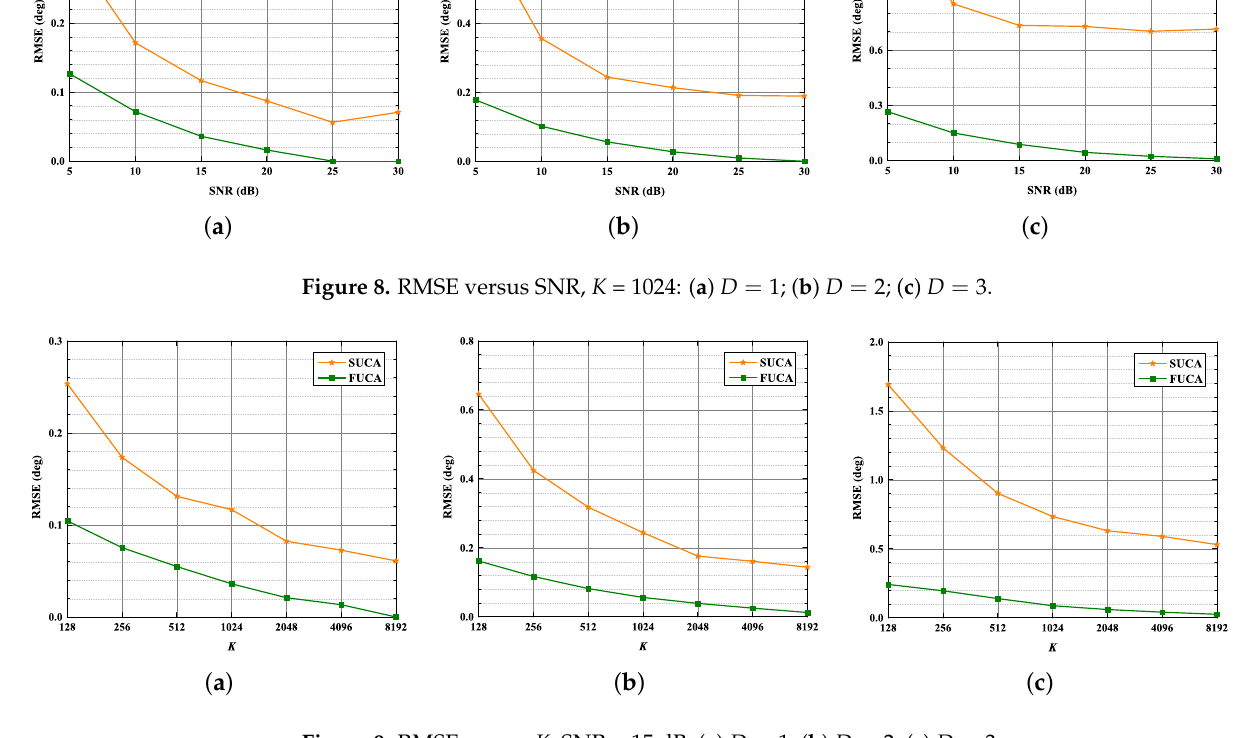
Figure 9. RMSE versus K , SNR = 15 dB: ( a ) D = 1; ( b ) D = 2; ( c ) D =